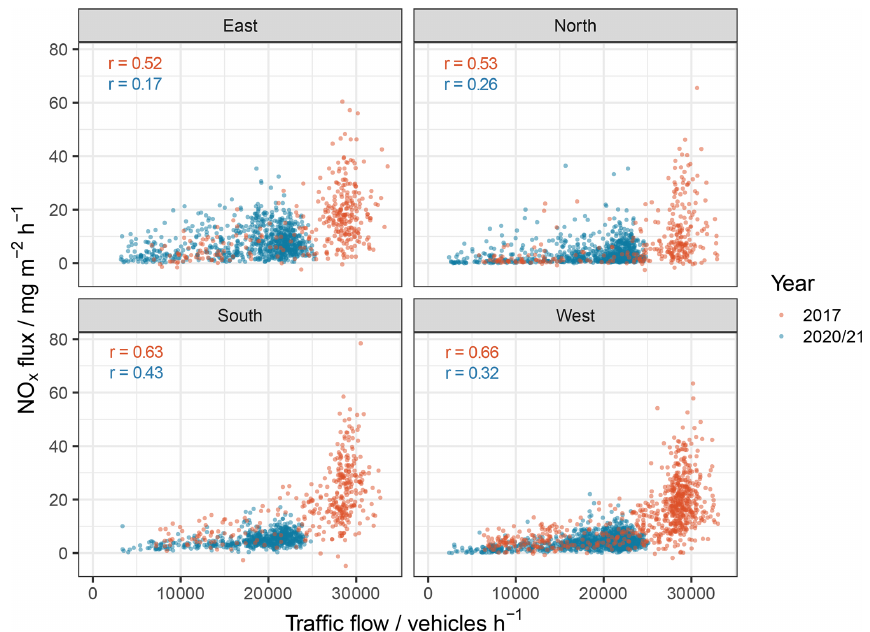
Figure 5. Comparison of the measured NO x flux with hourly traffic load (sum of the 24 surrounding ATCs) for March through August 2017 (red) and September 2020–September 2021 (blue). The data are split by wind direction: north (315–45 ◦ ), east (45–135 ◦ ), south (135–225 ◦ ) and west (225–315 ◦ ). In the top left of each facet is the Spearman correlation coefficient for each year for the corresponding wind